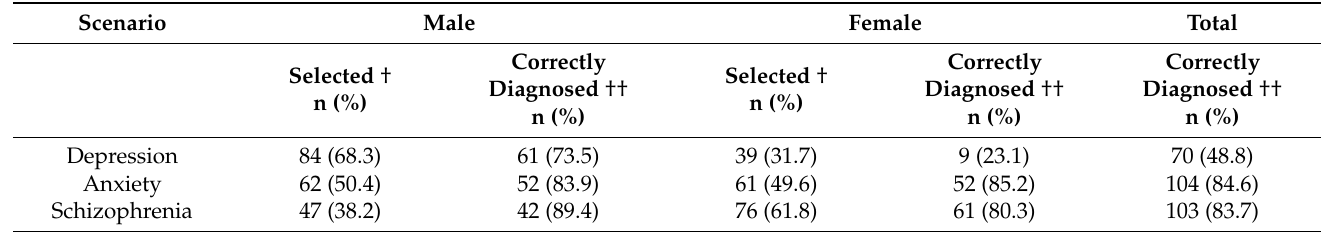
Table 2. Correctly diagnosed mental health